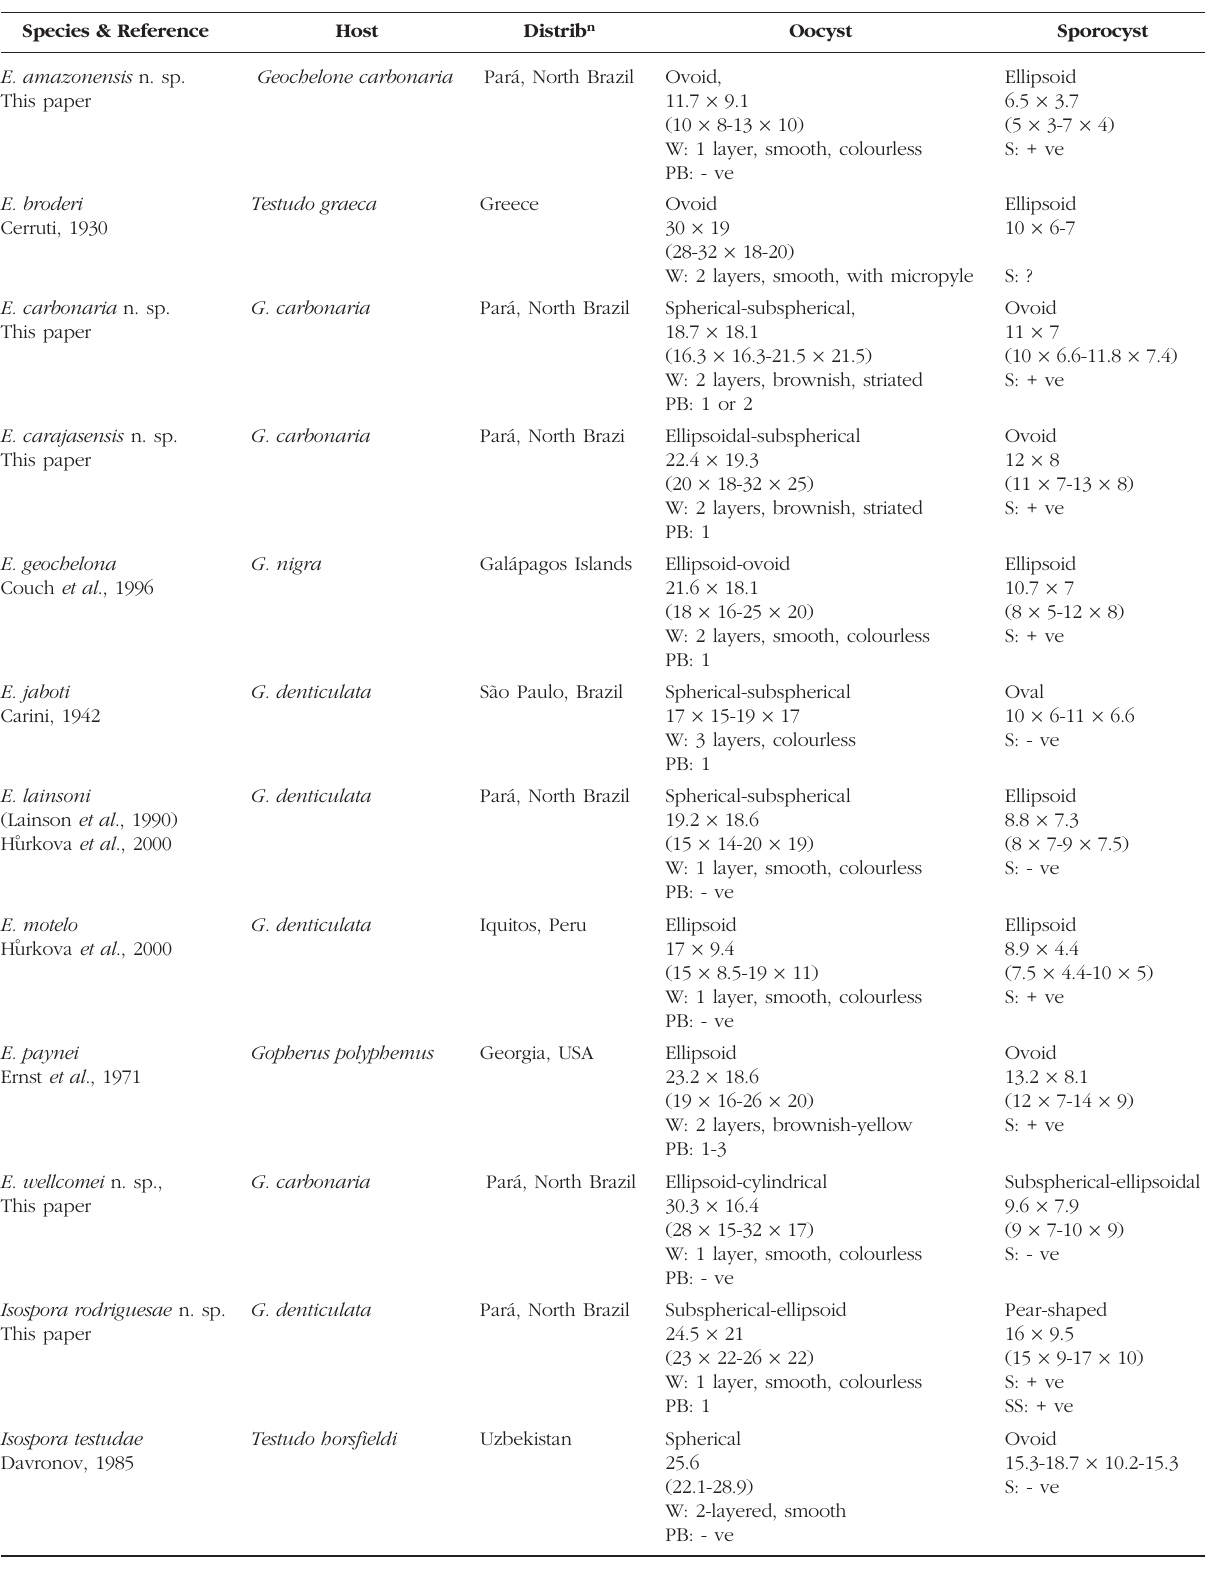
Table I. – Morphological features, hosts and known geographical distribution of Eimeria and Isospora spp., in tortoises of the family Tes-